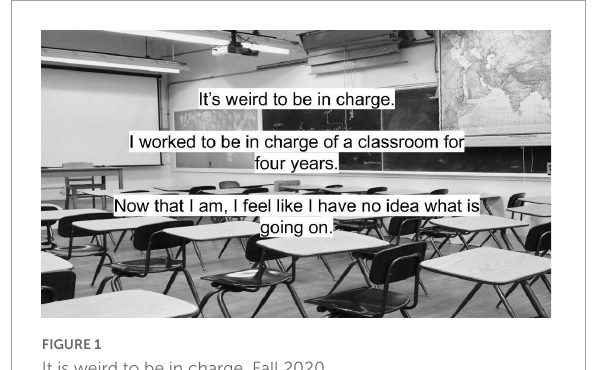
FIGURE1 It is weird to be in charge, Fall